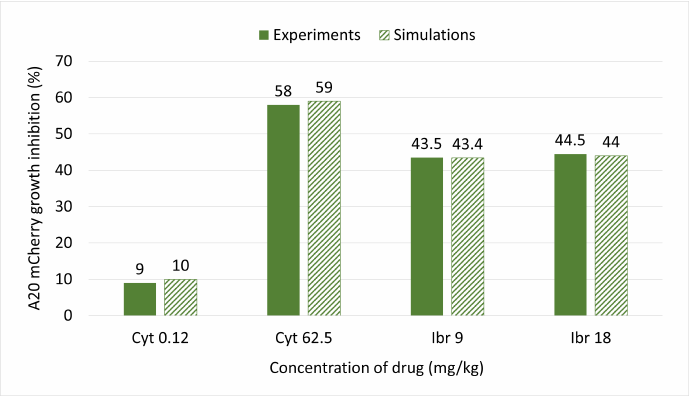
Figure 5. Comparison of inhibition of A20 mCherry cell growth under the influence of different doses of Ibr or Cyt between the model simulations (textured bars) and experimental data (fill